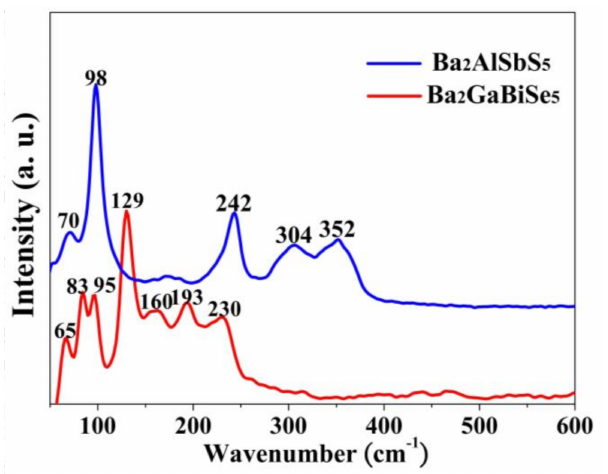
Figure 6. Raman spectra of title compounds.